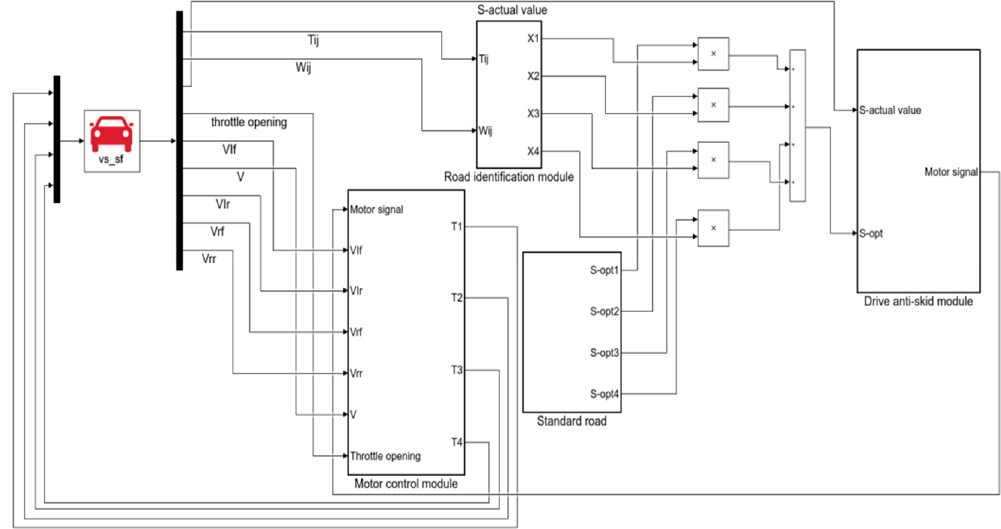
Figure 10. Simulation model of driving anti-skid control strategy.